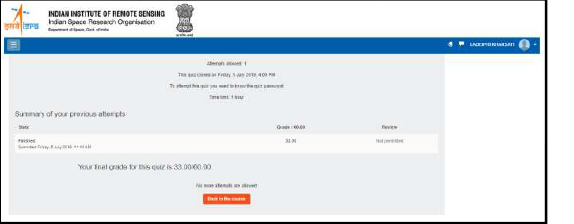
Figure 11. A Certificate of the